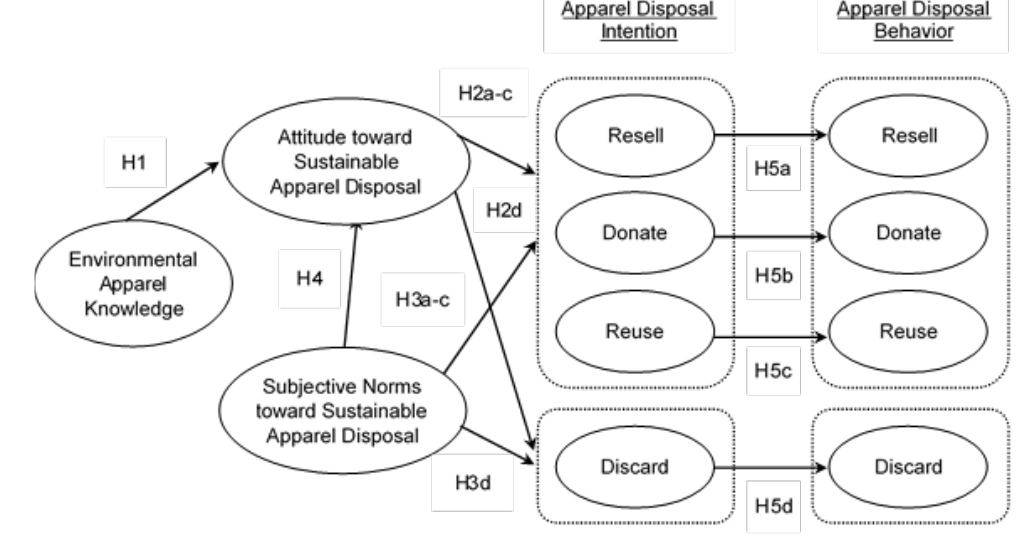
Figure 1: Conceptual Model; Source: